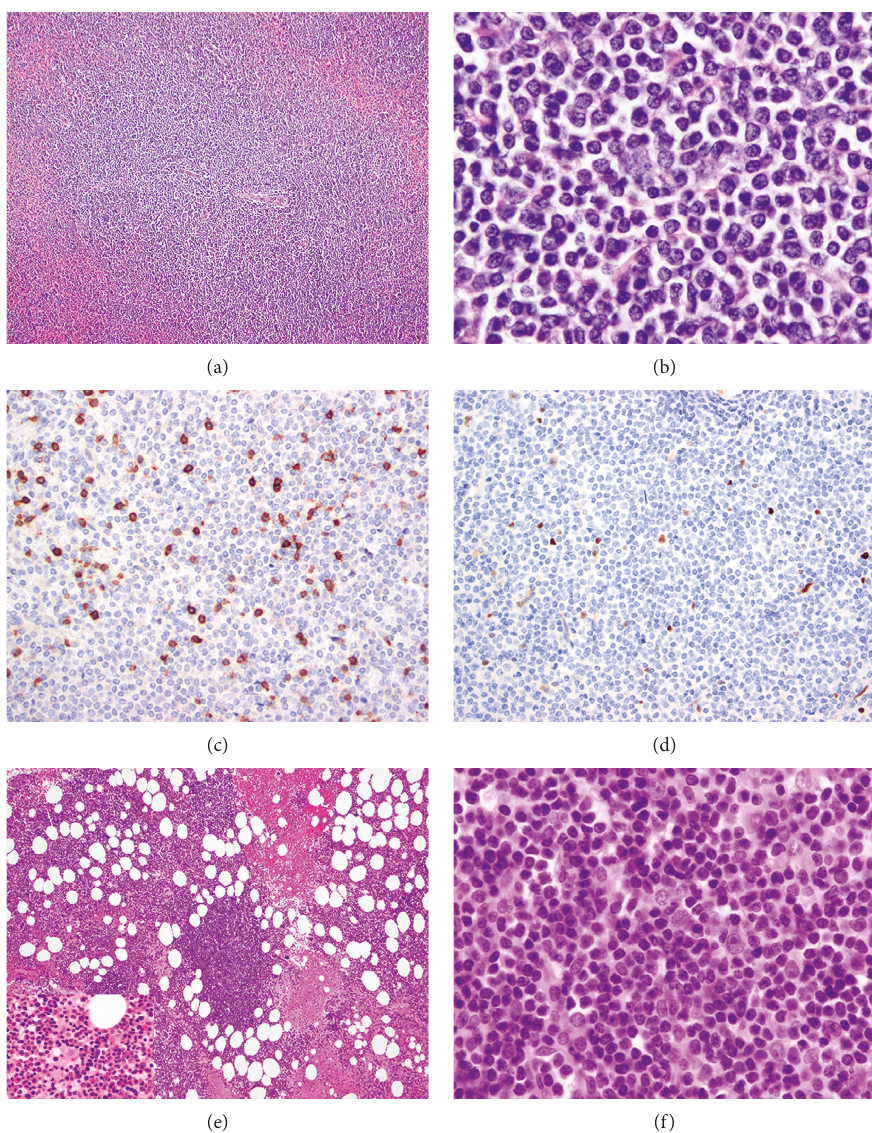
Figure 2: Case 1: splenic marginal zone lymphoma and staging bone marrow biopsy. Lymphoma cells are seen in a micronodular distribution expanding splenic white pulp and infiltrating adjacent red pulp (a) and are small with monocytoid morphologic features and minimal cytologic atypia (b). Tumor cells expressed CD20 (not shown) and were negative for CD5 and cyclin D1 (c and d). Bone marrow staging biopsy showed extensive involvement by lymphoma present predominantly in an interstitial nodular distribution with a focal sinusoidal pattern of involvement (inset in (e) showing focal sinusoidal distribution). Lymphoma cells were small in size and prolym- phocytic or large cell transformation was not seen (f). (a, b, e, and f) Hematoxylin and eosin stain, (a and e) 100 times magnification, (b and f) 500 times magnification; CD5 (c) and cyclin D1 (d) immunohistochemistry stains shown at 400 and 200 times magnification,